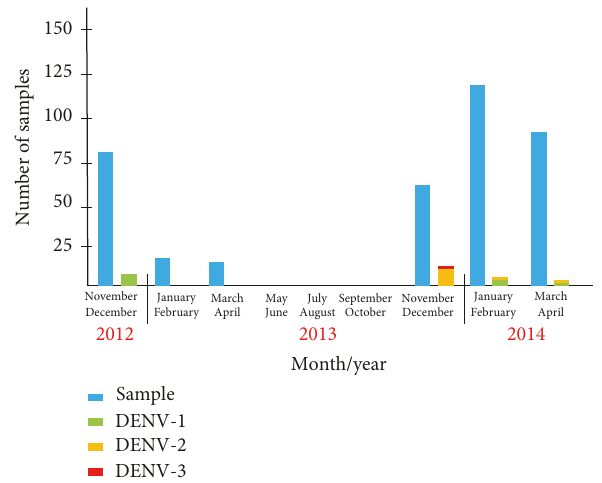
Figure 1: Monthly data on collected sera and isolated DENVs in Bangkalan between 2012 and 2014. The number of serum samples was shown in blue. Isolation numbers of DENV-1, DENV-2, and DENV-3 were shown in green, yellow, and red, respectively. DENV- 4 was not isolated during the study